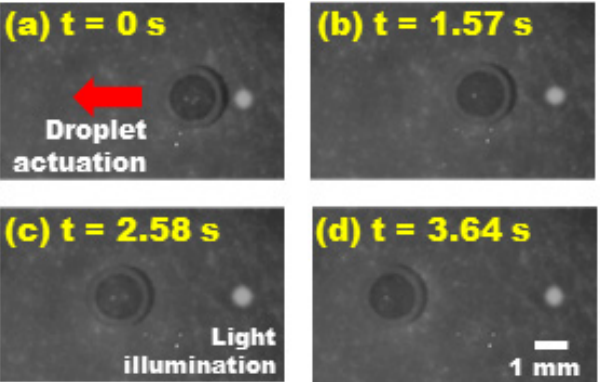
Figure 6. Video snapshots of light-actuated DEP droplet movement on a FEOET device with a 4.0 µm nanoparticle layer. ( a ) A laser beam (4.0 mW, 635 nm, 0.9 mm spot size) was illuminated near an edge of the droplet. ( b ) The droplet was repelled away from the light illumination area. ( c ) It reached its maximum instantaneous speed of 1.90 mm/s at x = 2.29 mm away from its original spot. ( d ) The droplet completely stopped at x = 3.44 mm.